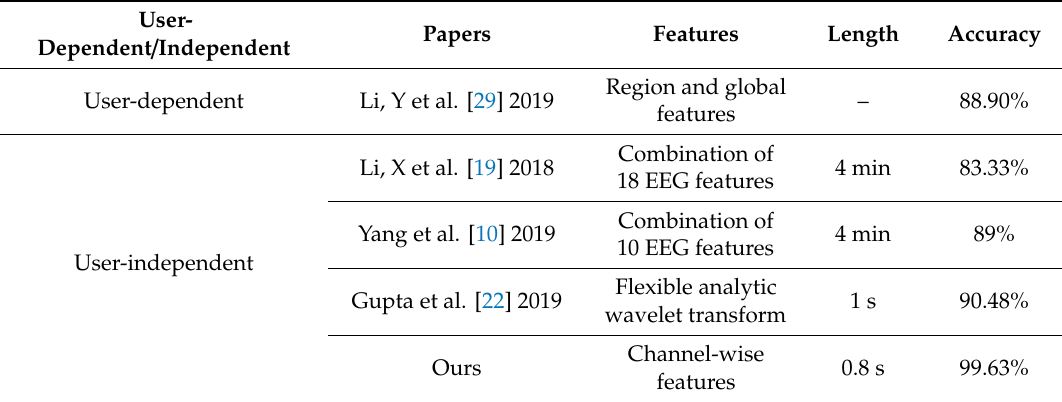
Table 3. Comparison between classification accuracy rates of our models and previous studies for two-class (positive, neutral, negative) classification of the